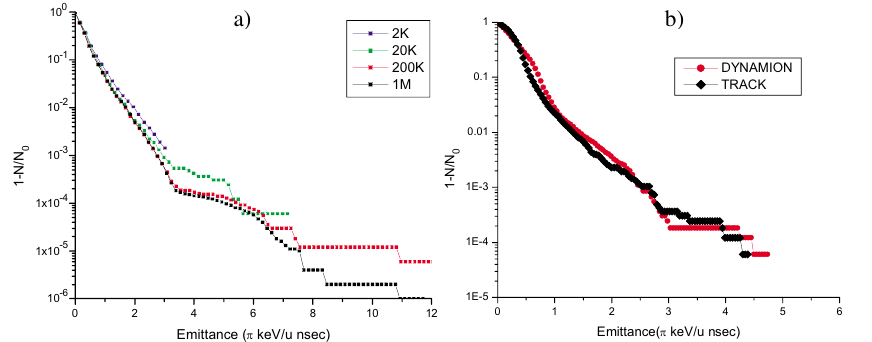
FIG. 7. (Color) Fraction of particles outside a longitudinal emittance given by the abscissa, (a) at the entrance of the SC linac obtained for different numbers of simulated particles and (b) at the exit of the RFQ obtained by the DYNAMION and TRACK codes. Space-charge effects are included in the